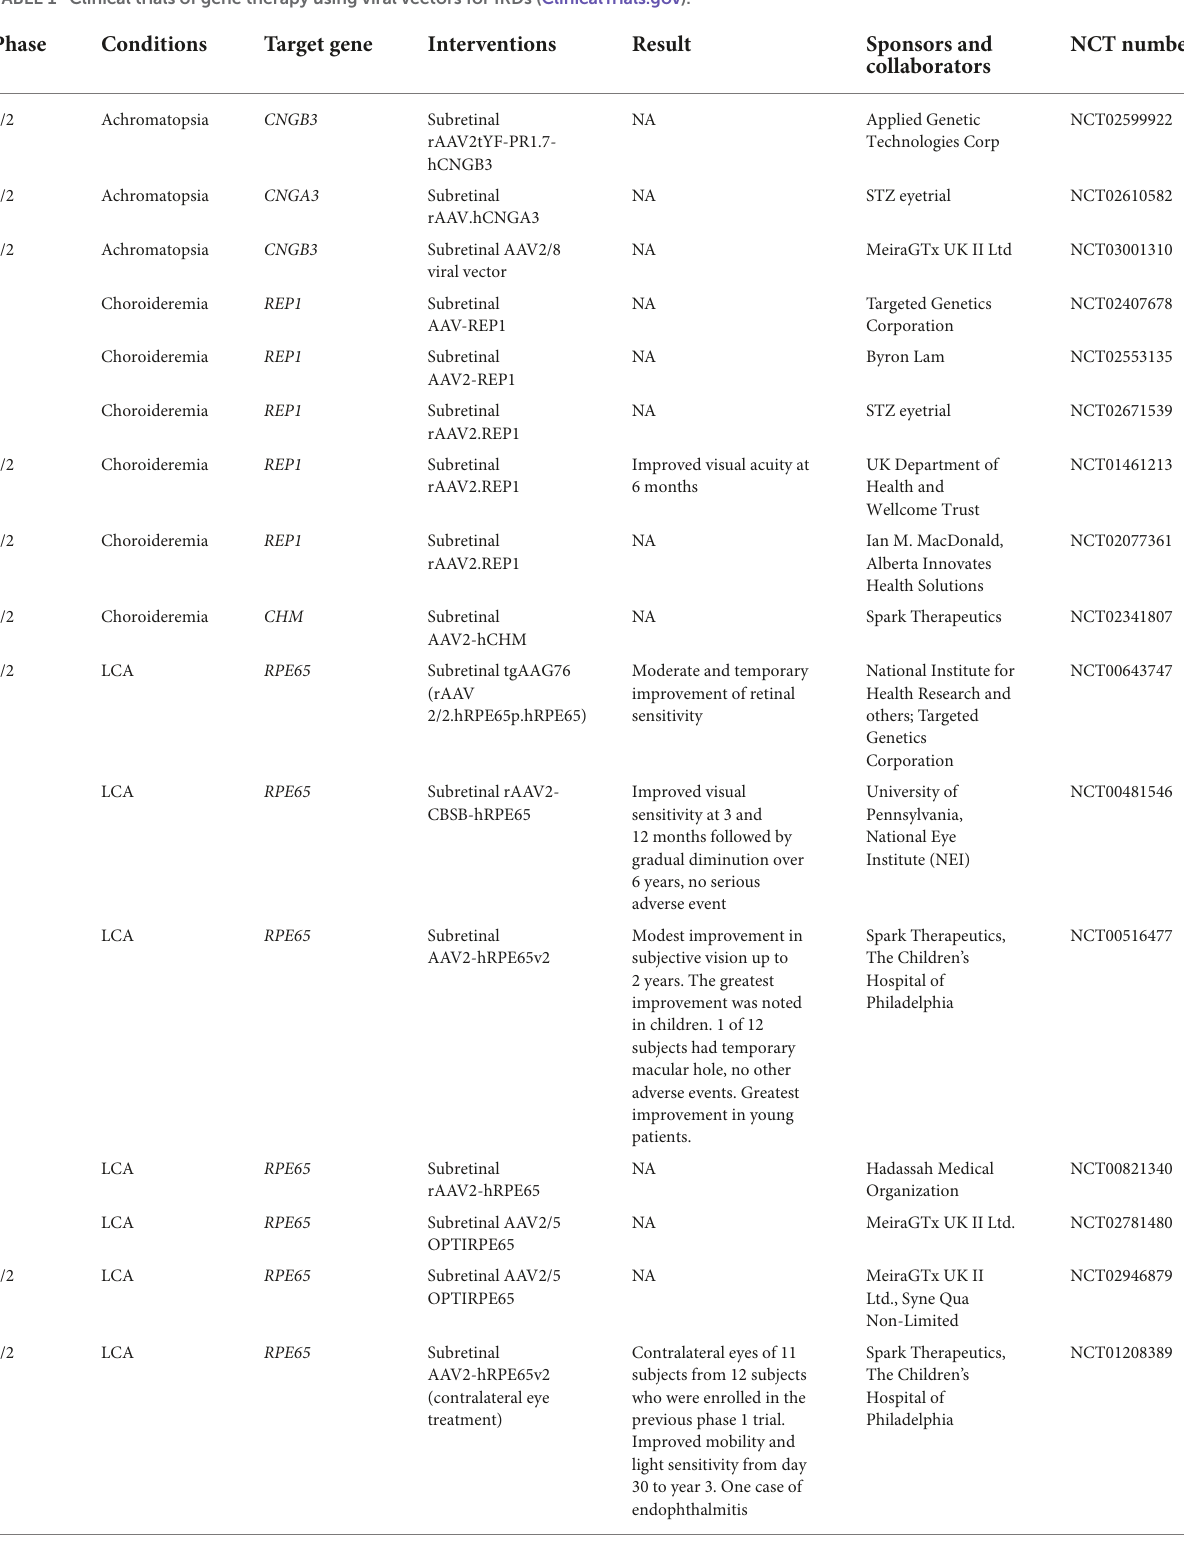
TABLE 1 Clinical trials of gene therapy using viral vectors for IRDs